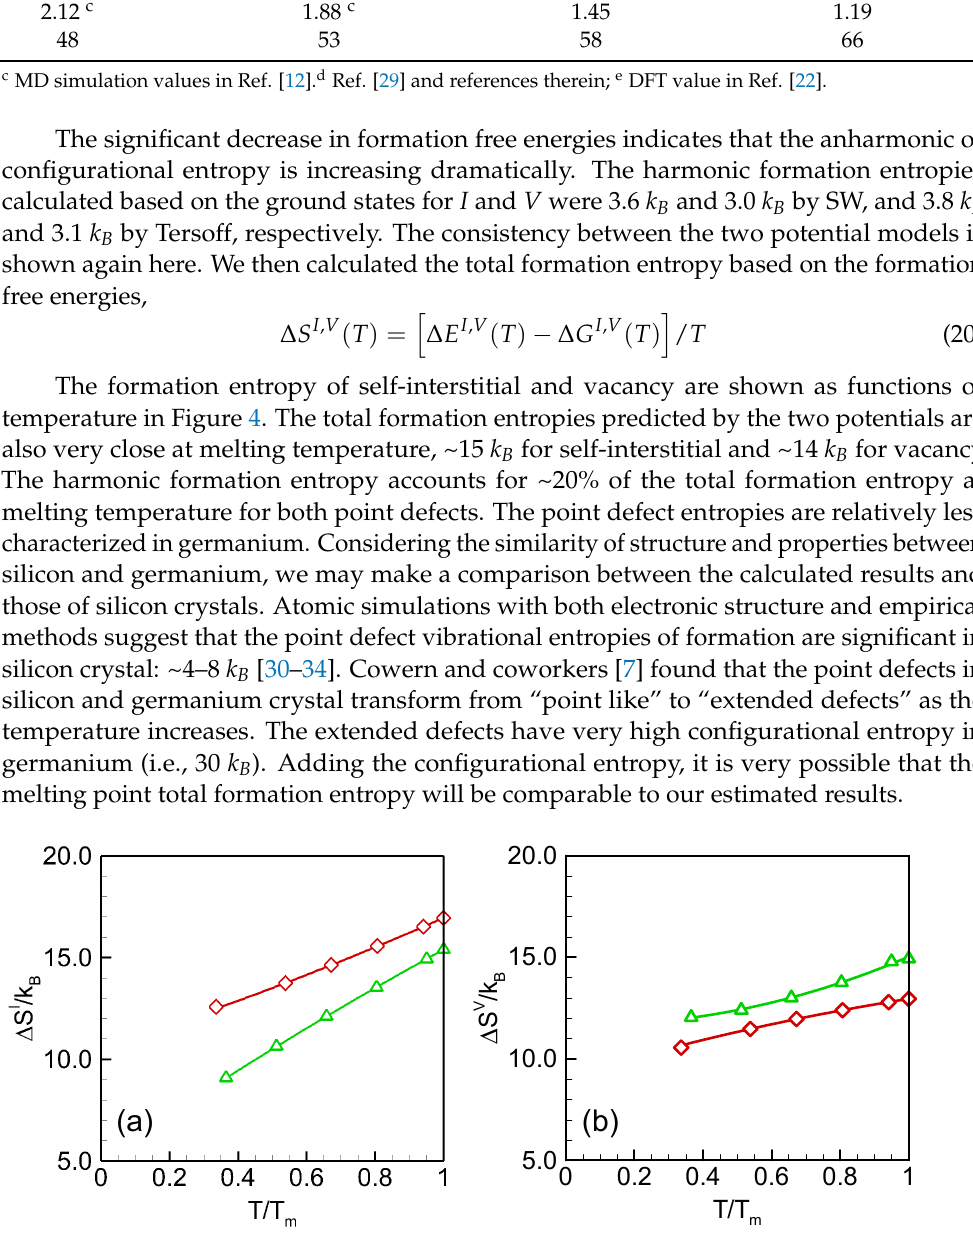
Figure 4. Formation entropies of ( a ) self-interstitial and ( b ) vacancy in germanium crystal. Red and green are results of SW and Tersoff, respectively. The lines are quadratic-fitted.